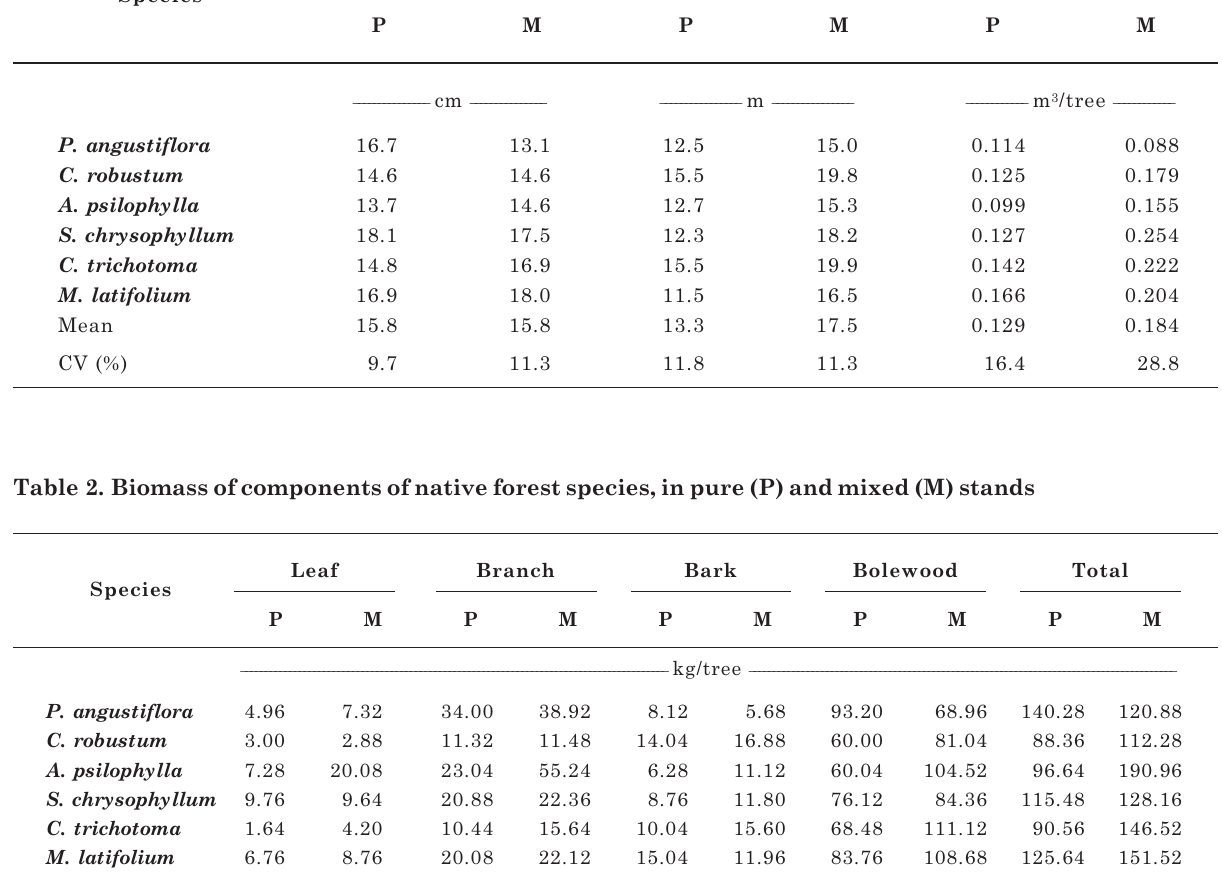
DBH TH VOL Species P M P